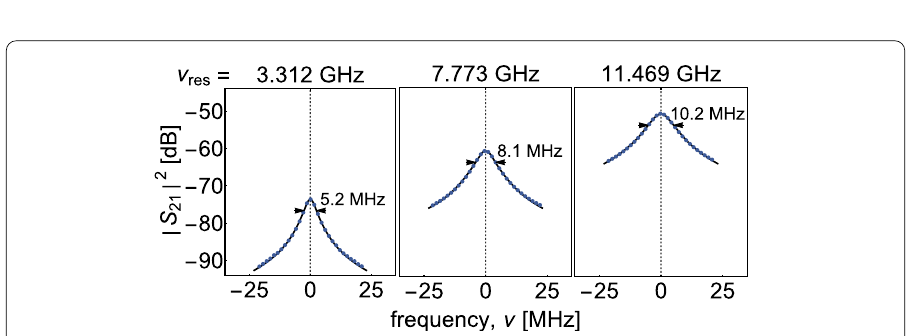
Figure 3 Illustration of analysis procedure for representative modes. Absolute value squared of the measured transmission | S 21 | 2 (dots) versus frequency ν at the indicated resonances for CC141Al (RT) and modes numbers n = { 26,61,90 } . The arrows indicate the full width at half maximum from which we extracted Q i . ν res is the center frequency of the resonance. The line is the absolute value squared of the simultaneous fit of the real and imaginary part of the S 21 scattering parameter (see Appendix 2 for details).